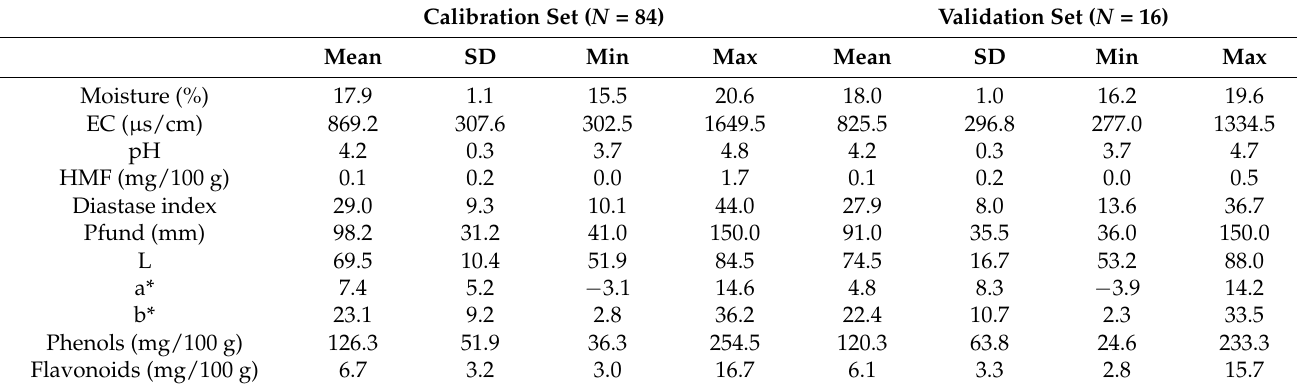
Table 1. Reference physicochemical data of honey samples selected for the calibration and validation